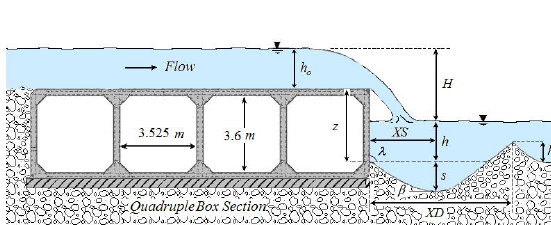
Figure 2 . A sketch of scour of an alluvial bed downstream of an inverted siphon